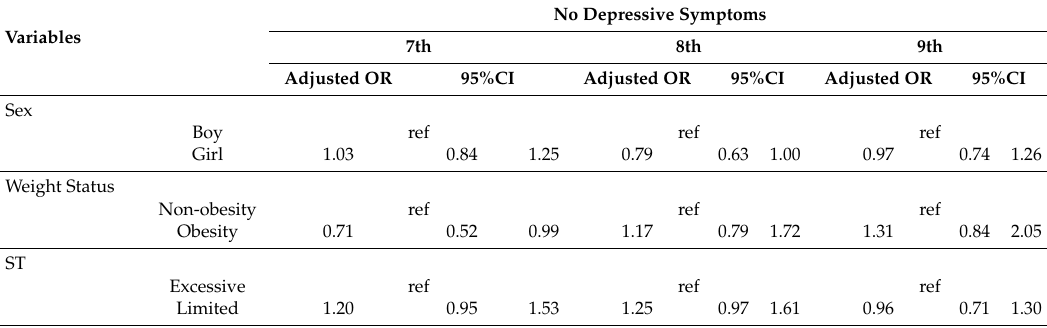
Table 5. Relationships of AST and control variables with no depressive symptoms by age